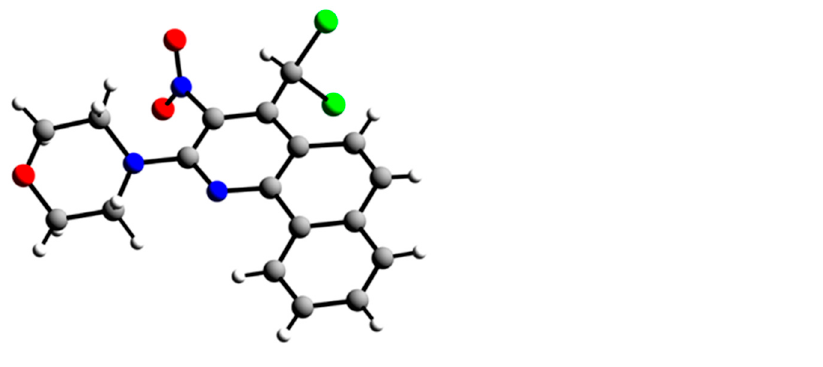
Figure 4. X-ray single-crystal structure of 4-(4-(dichloromethyl)-3-nitrobenzo[ h ]quinolin-2-yl)mor- pholine ( 11b